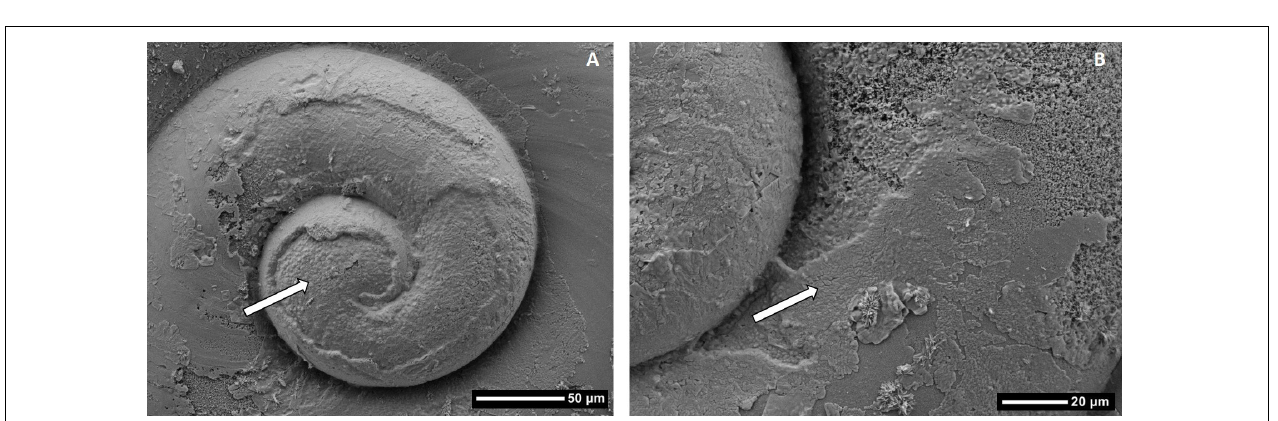
FIGURE 8 | Distribution and extent of Limacina helicina shell dissolution (Type I, II, or III) in the Amundsen Gulf. 2014 and 2017 data are combined for upwelling, embayment and gateway areas.